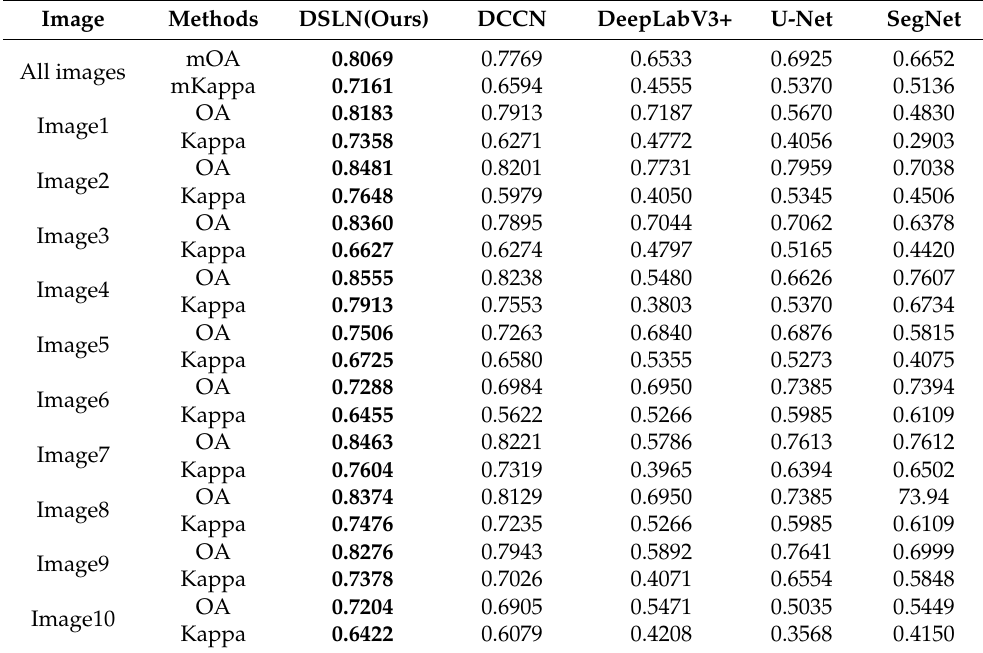
Table 3. Comparison of LCC Accuracy of Different